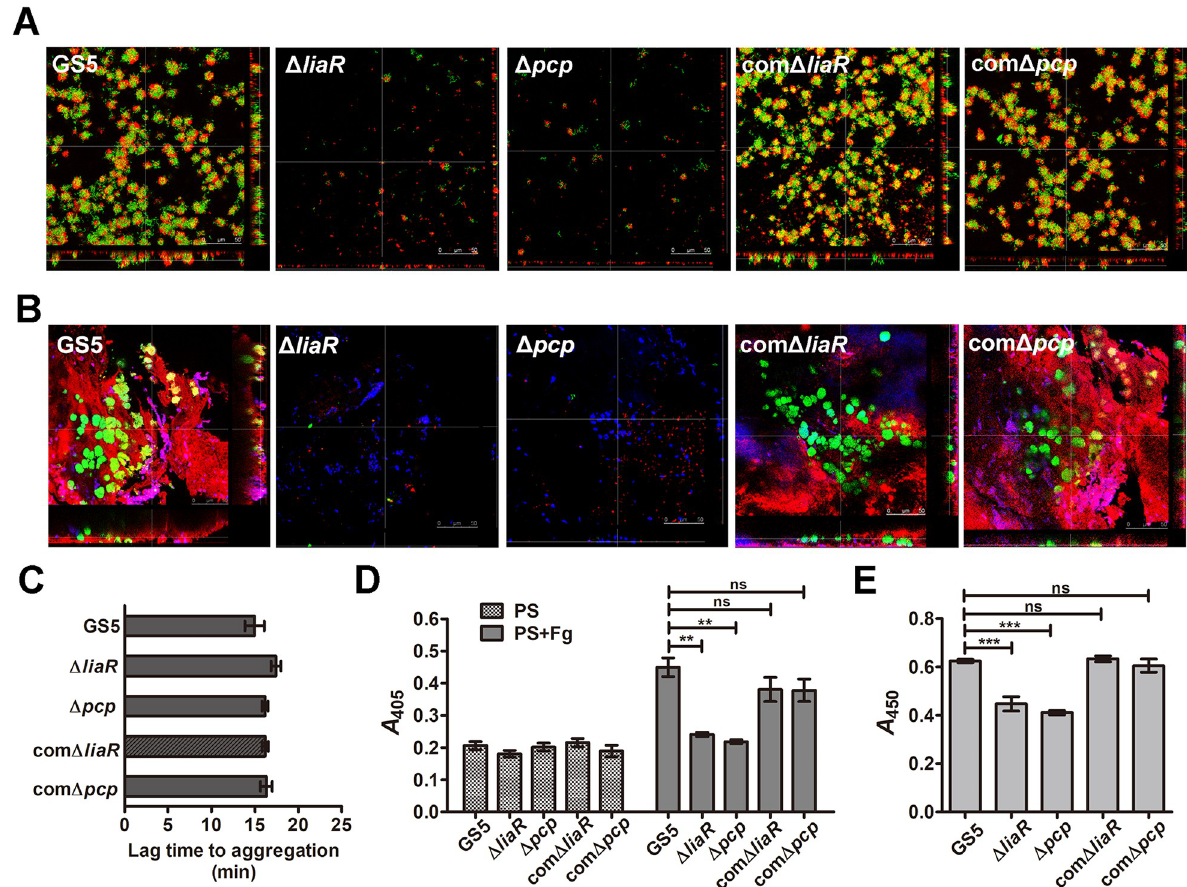
Fig 6. PCP mediates bacterial biofilm formation with platelets in vitro and in vivo . (A) Biofilms of S . mutans GS5 wild type, Δ liaR , Δ pcp , com Δ liaR , and com Δ pcp grown in PRP were observed by CLSM (magnification 630 × ). S . mutans were labeled with GFP (green), and platelets were stained with rhodamine-conjugated phalloidin (1:200 dilution). (B) Biofilms of S . mutans GS5 wild type, Δ liaR , Δ pcp , com Δ liaR , and com Δ pcp inside vegetation harvested from injured heart valves were observed by CLSM (630 × magnification). S . mutans were labeled with GFP (green), and platelets were stained with an anti-CD42d antibody (1:50 dilution) followed by a rhodamine-conjugated secondary antibody (1:200 dilution). (C) Platelet aggregation was measured by a Lumi-Aggregometer. Bacterial ability to induce platelet aggregation was evaluated by detecting the lag time, which indicates the time between the addition of bacterium to the PRP suspensions and onset of aggregation response. Data are expressed as the means ± standard deviations of triplicate experiments. (D) Microtiter plate wells were coated with S . mutans GS5 wild type, Δ liaR , Δ pcp , com Δ liaR , or com Δ pcp strains then platelet suspensions with or without 100 μ g/mL Fg were added. Platelet adherence was measured by acid phosphatase activity (OD 405 ) as described in the Materials and Methods. Data are expressed as the means ± standard deviations of triplicate experiments; �� P < 0.01 by 1-way analysis of variance. ns, not significant. (E) Binding capacity to immobilized Fg were compared. Microtiter plate wells were coated with Fg, and bacteria suspensions ( S . mutans GS5 wild type, Δ liaR , Δ pcp , com Δ liaR , or com Δ pcp ) were added. The adhered bacteria were measured as described in the Materials and Methods. Data are expressed as the means ± standard deviations of triplicate experiments; ��� P < 0.001 by 1-way analysis of variance. ns, not significant. These experiments were replicated thrice, with a representative experiment shown. PRP, platelet rich plasma; GFP, green fluorescent protein; CLSM, confocal laser scanning microscopy; IE, infective endocarditis; Fg, Fibrinogen; and PS, platelet